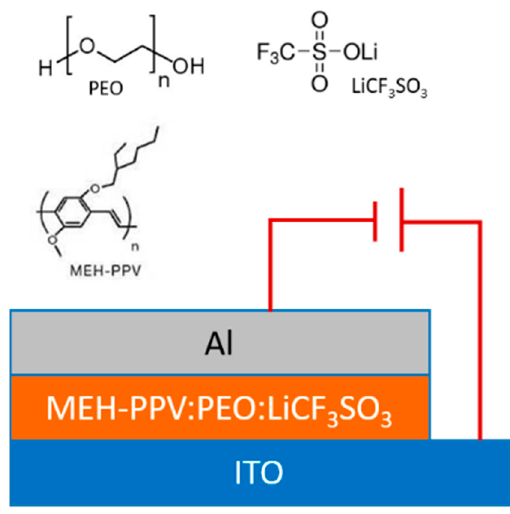
Figure 1. The chemical structures of these materials and the schematic view of the light-emitting electrochemical cells (LEC)